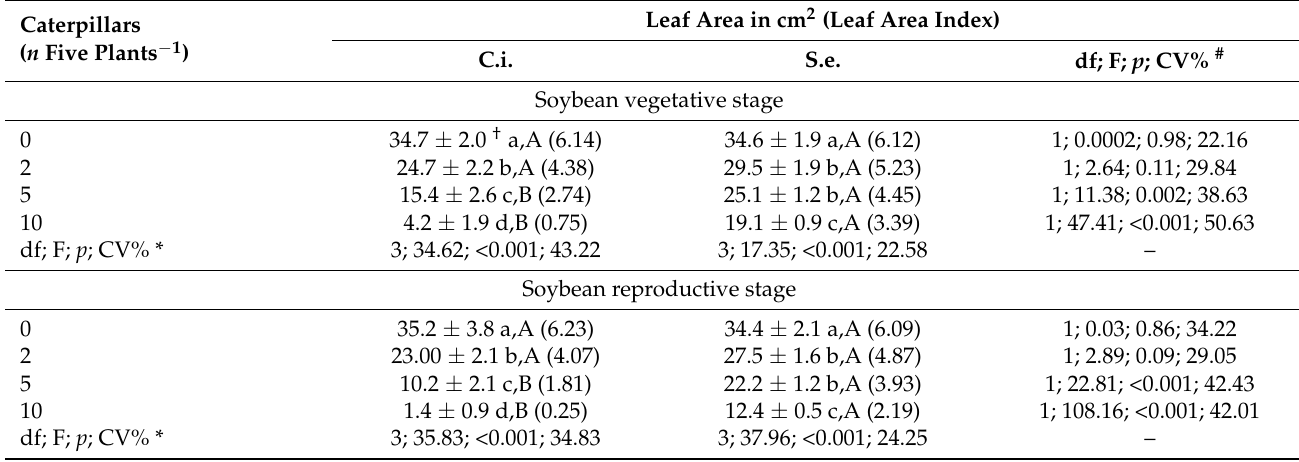
Table 2. Soybean leaf consumption by Chrysodeixis includens and Spodoptera eridania in different population